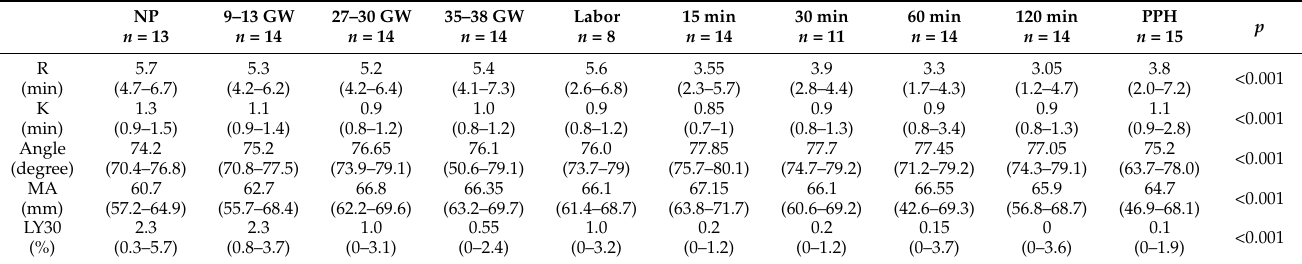
Table 2. The results of thromboelastographic parameters in CK assay obtained with TEG6s ®